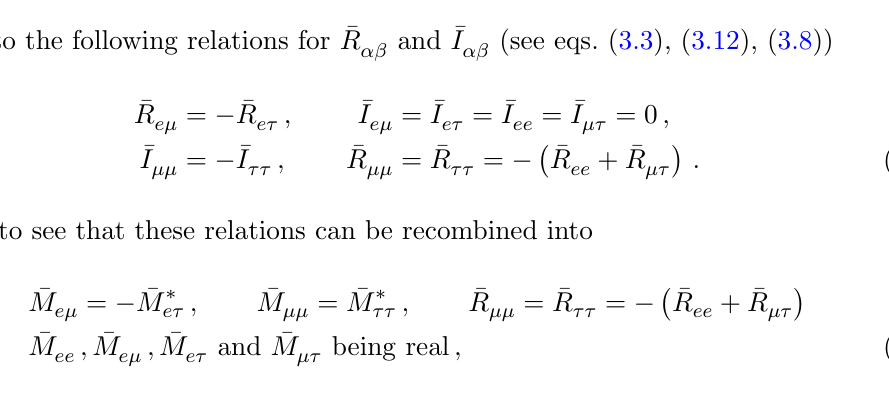
in the case of two sides 3